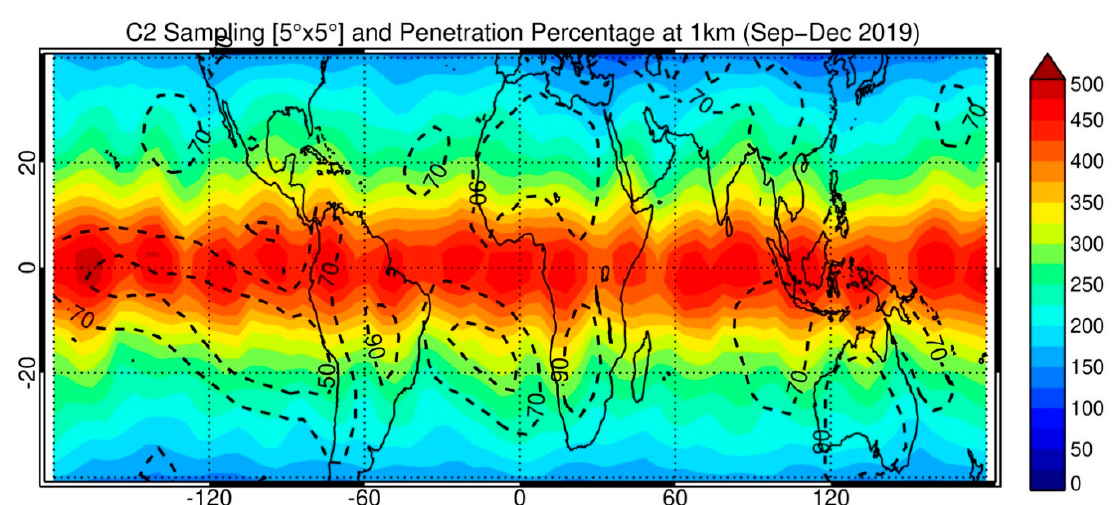
Figure 1. C2 sampling using 5 ° × 5 ° grids (color contours) along with penetration percentage to at least 1 km above the surface (dashed contours) from September–December 2019.